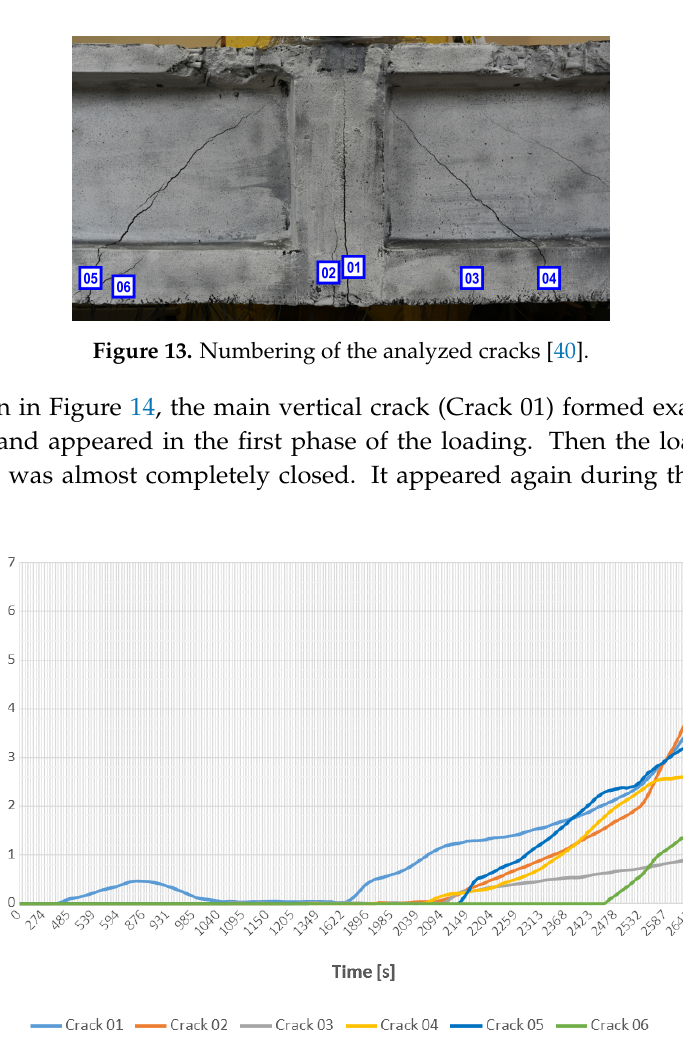
Figure 14. The crack width development during the loading phases.